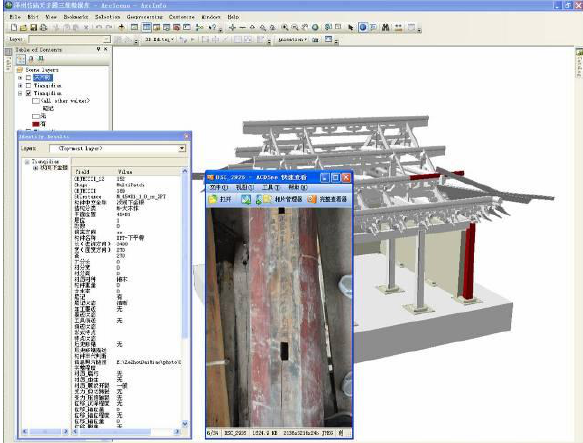
Figure 15 The inscription photo pop-up by click on the multipatch in